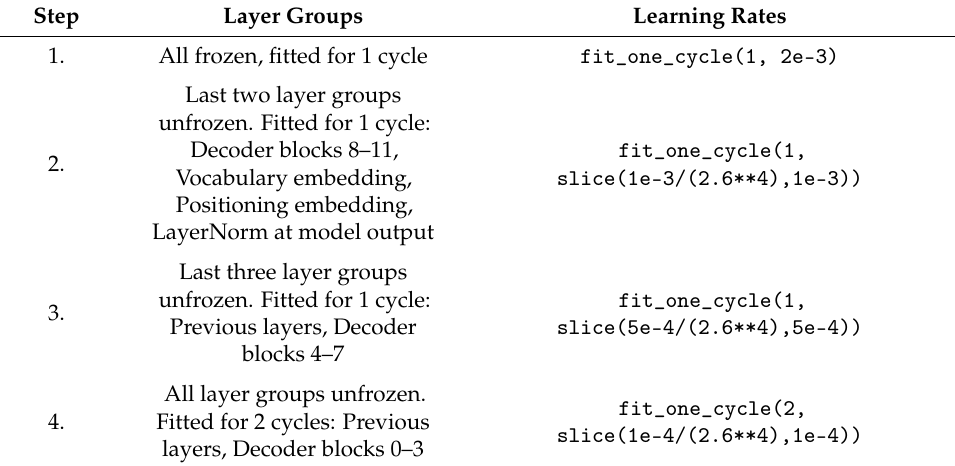
Table A1. Fine-tuning steps of GPT-2. The fastai library was used to split layer groups and to fine-tune the model with one-cycle policy [29]. Differential learning for several layers is applied by passing an array of learning rates fit_one_cycle() (https://docs.fast.ai/callback. schedule.html#Learner.fit_one_cycle, accessed on 19 May 2021). Training parameters from